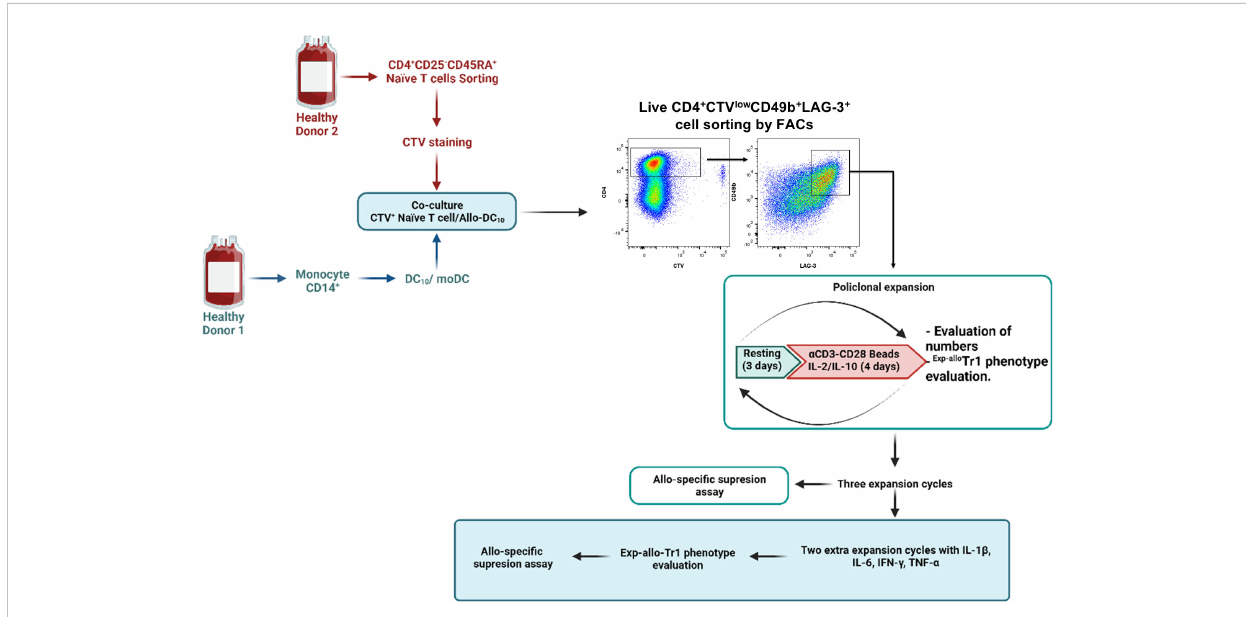
FIGURE 1 General methodological scheme used for the expansion of Allo Tr1 regulatory type 1 cells. FACS-sorted CD4 + CD25 - CD45RA + nT cells (labeled with CTV) were stimulated with allogeneic DC 10 in the presence of exogenous IL-2 and IL-10 for 14 days. Proliferating Allo Tr1 cells ( CD49b + LAG-3 + CTV - ) were puri fi ed by FACs from co-cultures (CD4 + nT cells:DC 10 ) and polyclonally-expanded for three cycles of stimulation (4 days of culture with anti- CD3/anti-CD28, rhIL-2 and rhIL-10)/resting (3 days of culture with only rhIL-2) of 7 days each. Exp-allo Tr1 cell phenotype was evaluated at each cycle of stimulation. In vitro functional assays were performed after three rounds of polyclonal expansion. Finally, long-term Exp-allo Tr1 cells were re- stimulated for two additional cycles in the presence of proin fl ammatory cytokines for Tr1 stability assays. Created by